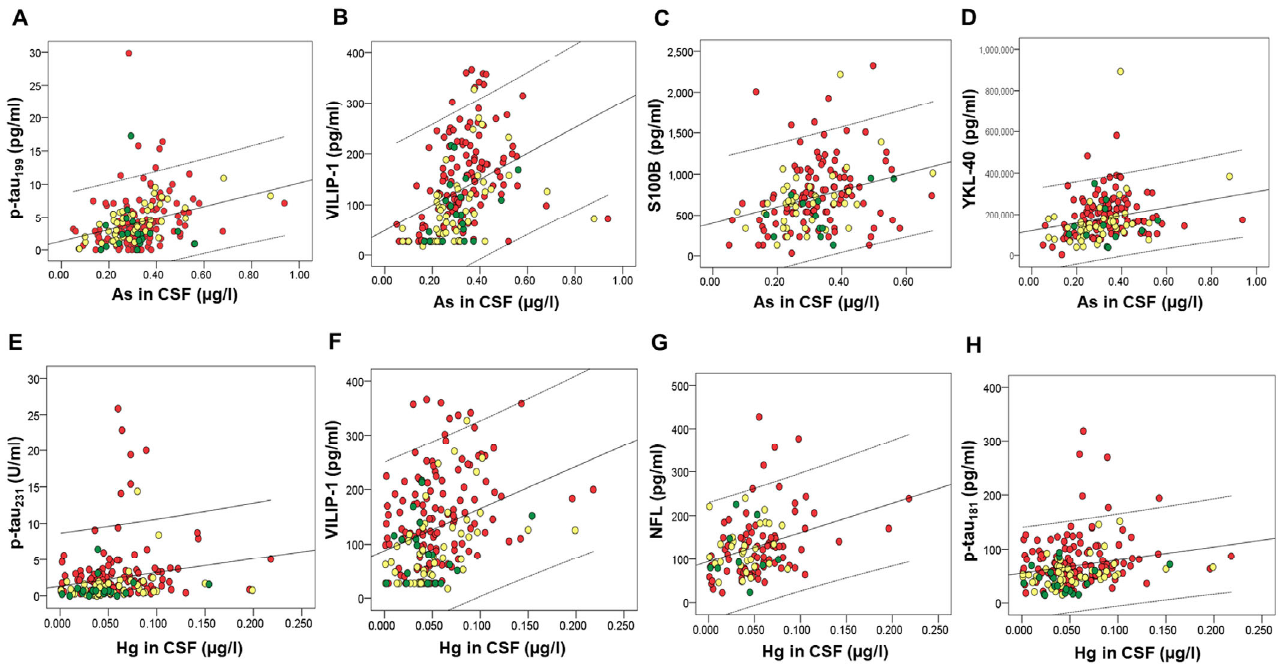
Figure 1. Correlation of CSF biomarkers of AD with As ( A – D ) and Hg ( E – H ) measured in CSF. Red circles represent AD patients, yellow circles represent MCI patients, while green circles represent healthy controls.